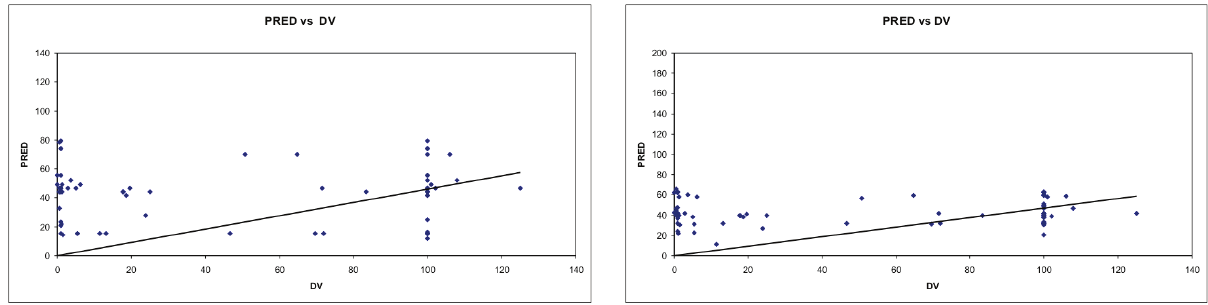
Figure 1: Predicted vancomycin concentrations versus measured concentrations for population with normal kidneys in the base model (A) and the final model (B), respectively.